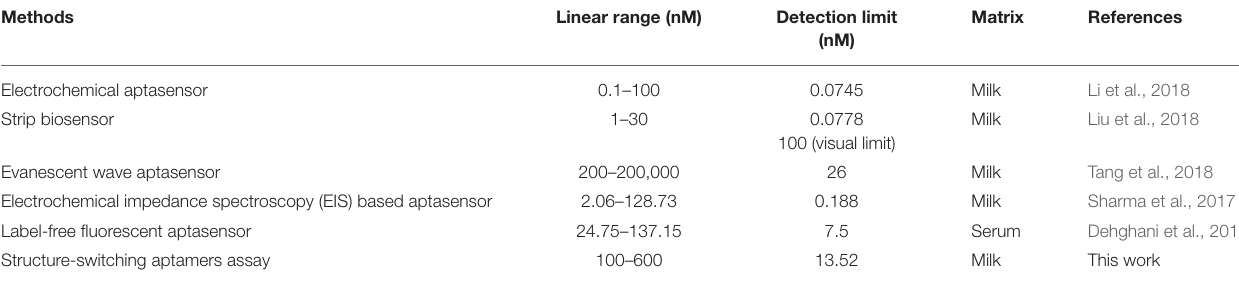
TABLE 2 | Comparison of various kanamycin detection methods using kanamycin-binding aptamer. Methods